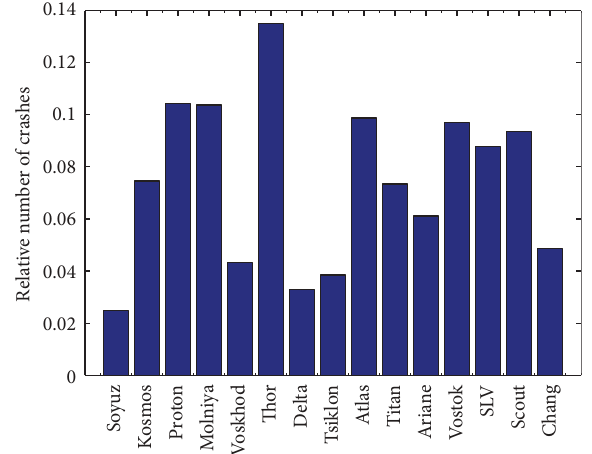
Figure 4: Relative number of crashes (the number of crashes normalized on a number of launches) for various types of